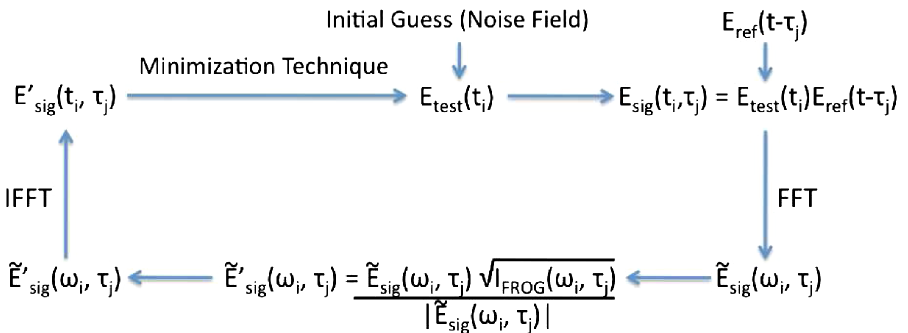
EXTENDING ELECTRO-OPTIC DETECTION TO . .